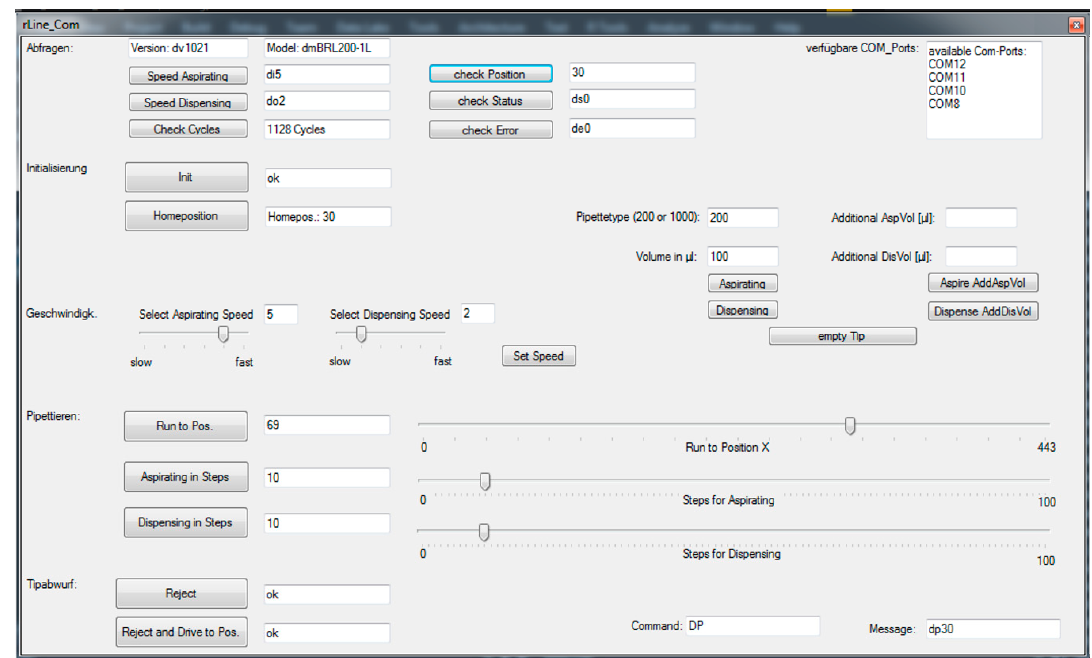
Figure 4. Graphical user interface (GUI) of the test software, rLine_Com, for pipette control and performance testing.